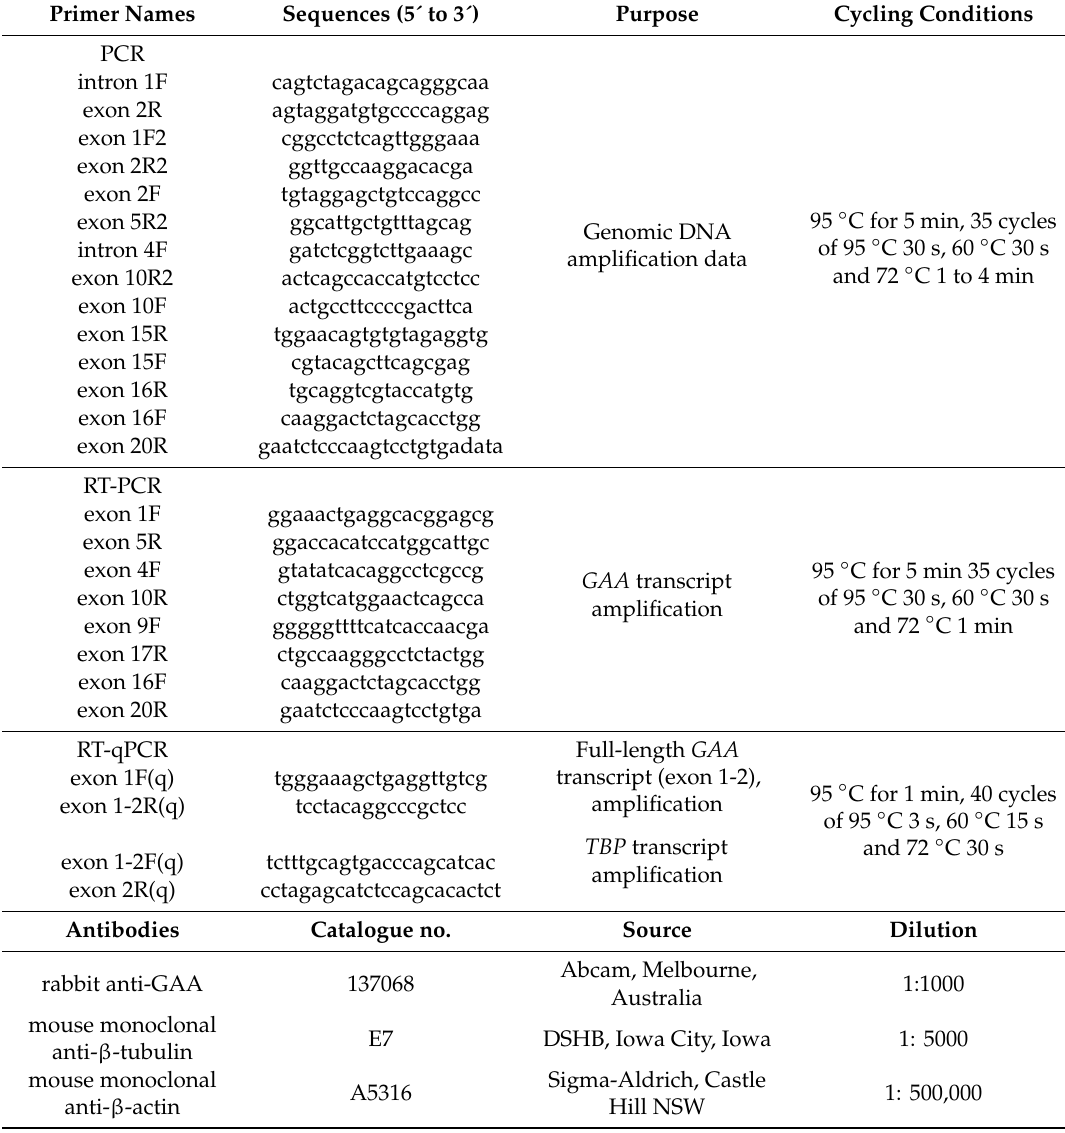
Table 1. Primers and antibodies used in this